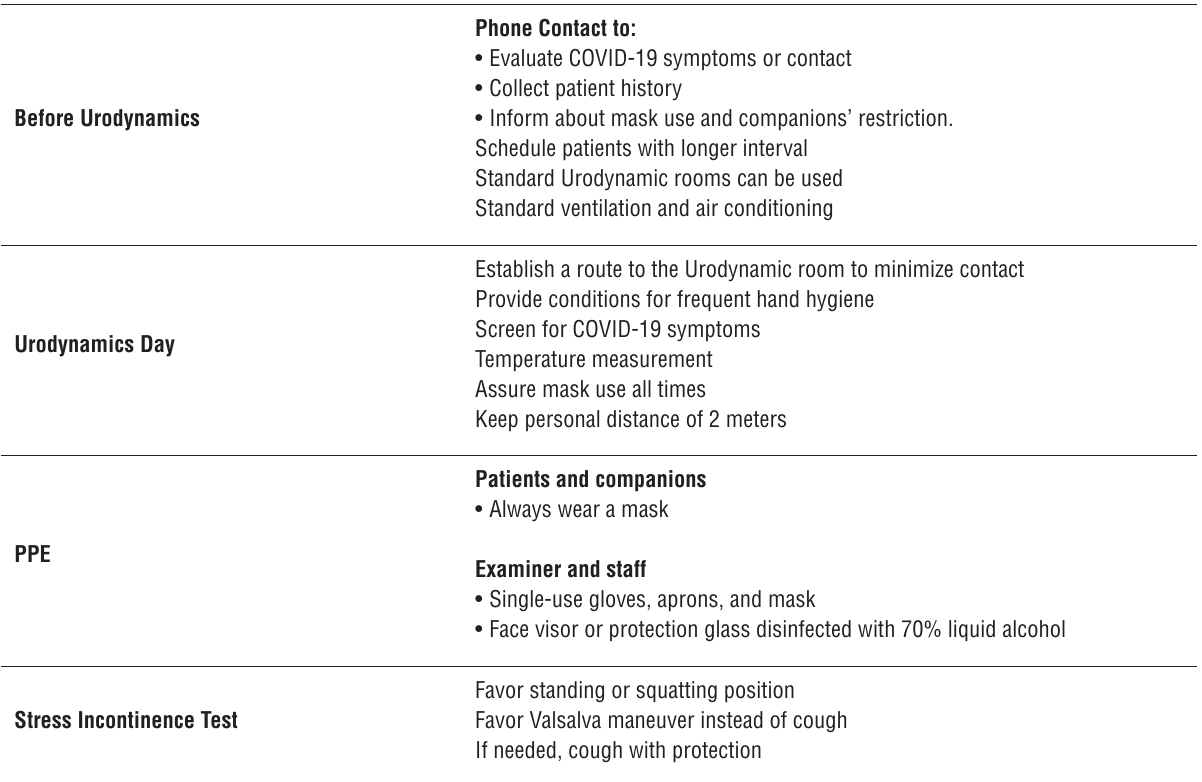
Table 2 – Adaptations for Urodynamic performance during COVI-10 pandemic.